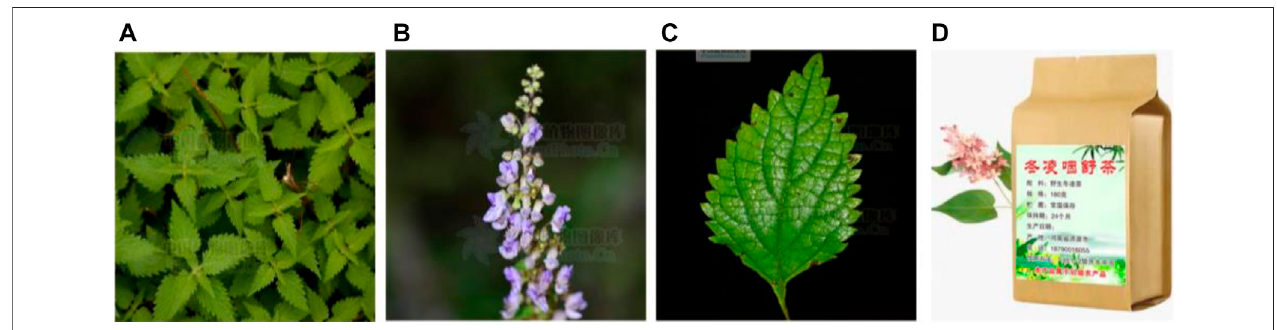
FIGURE 1 | The aerial part (A) , Plant fl ower (B) , Plant leaves (C) (http://ppbc.iplant.cn/), and I. rubescens tea (D)